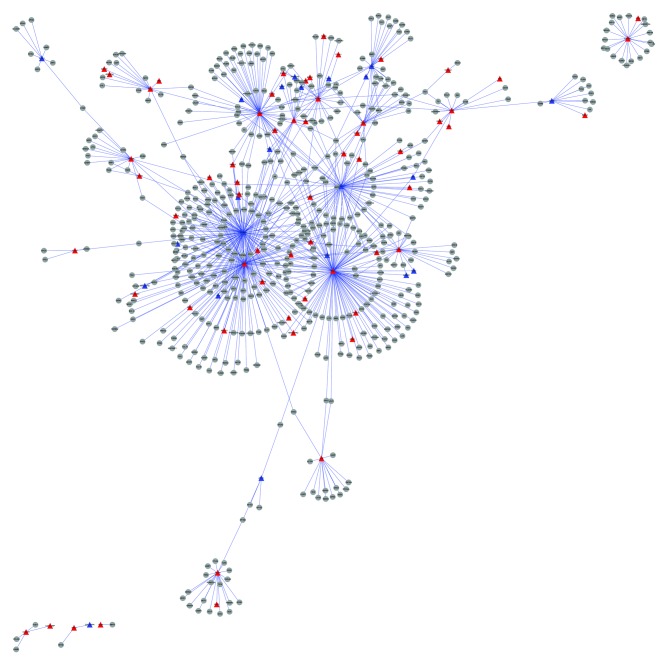
Protein-protein interaction network for DEGs involved in significantly enriched pathways. The red, blue and grey nodes, and grey edges represent the upregulated DEGs, downregulated DEGs, other genes and protein-protein interactions, respectively. DEGs, differentially expressed genes.